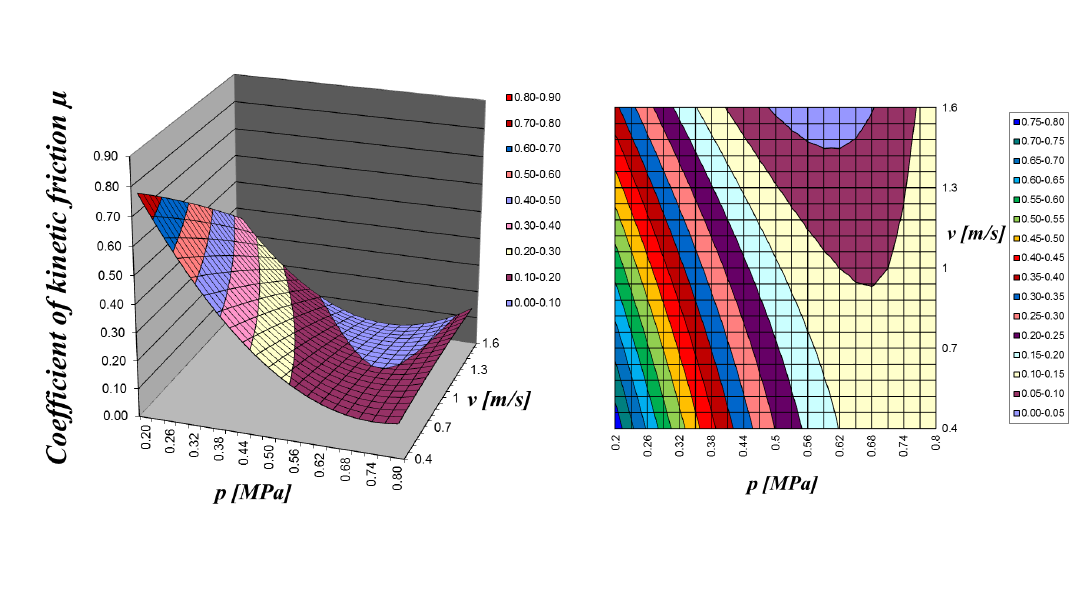
Figure 2: Coeflcient of friction of EPUR with hardness of 75 ∘ Sh A after steel dampened with water depending on the pressure p and sliding speed v